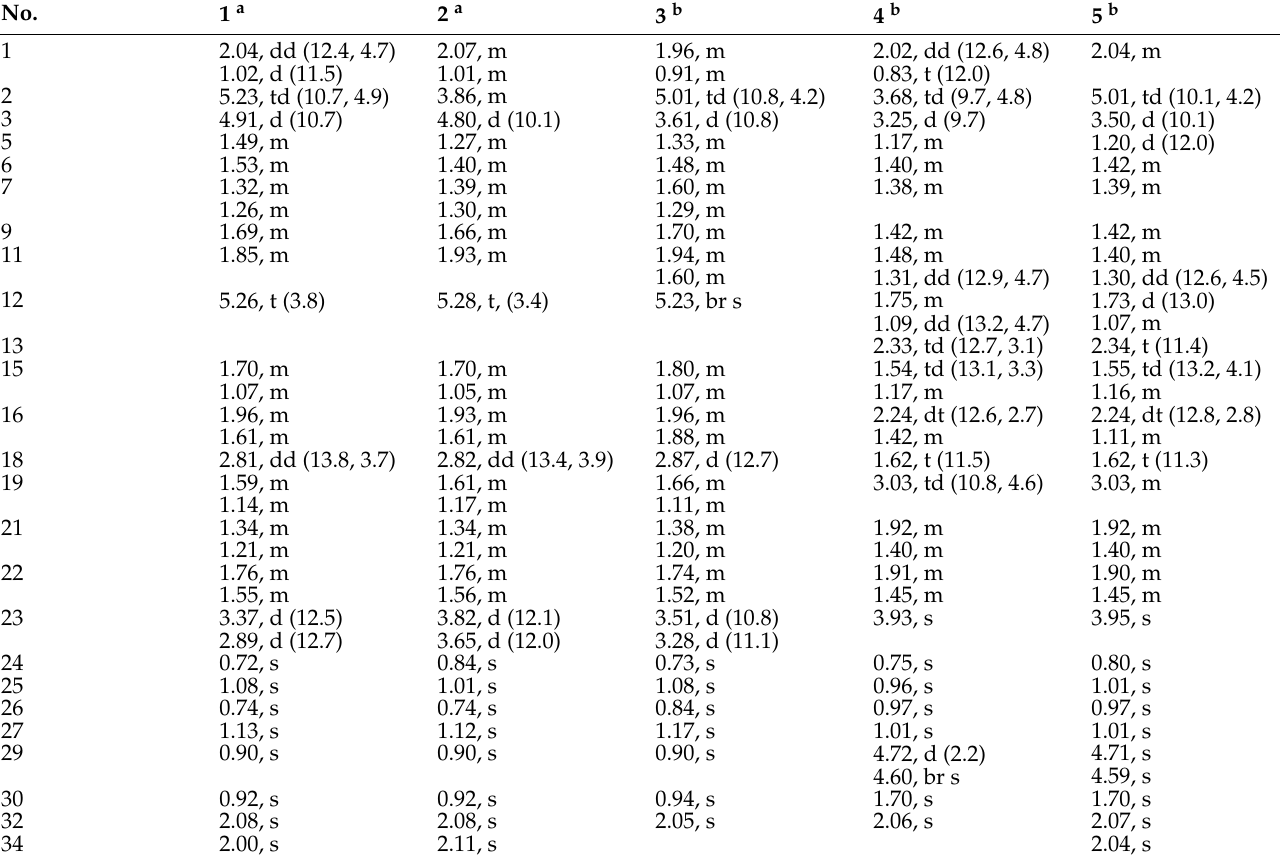
Table 1. 1 H NMR spectroscopic data of 1 – 6 measured at 600 MHz [ δ H , mult. ( J in